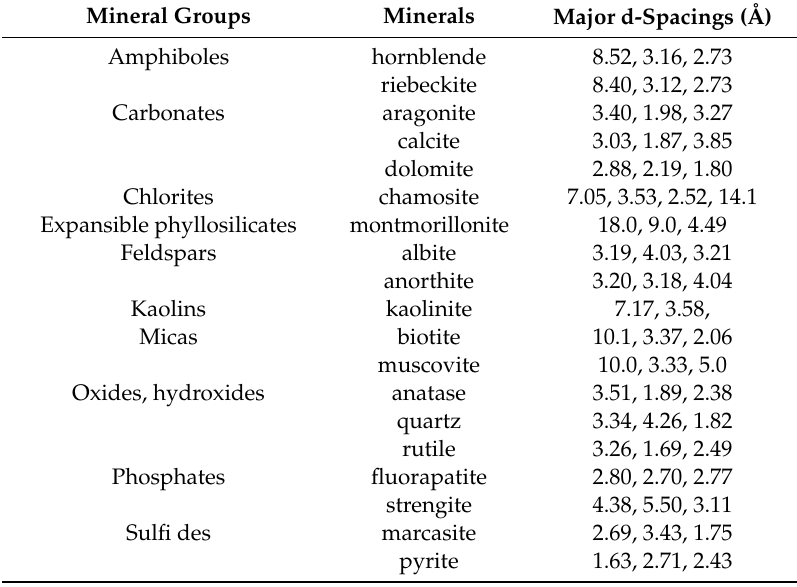
Table 2. Major d-spacings for some minerals that occur in soils, listed for each mineral in the commonly observed order of decreasing X-Ray Di ff raction (XRD) peak intensity (Source [44]).